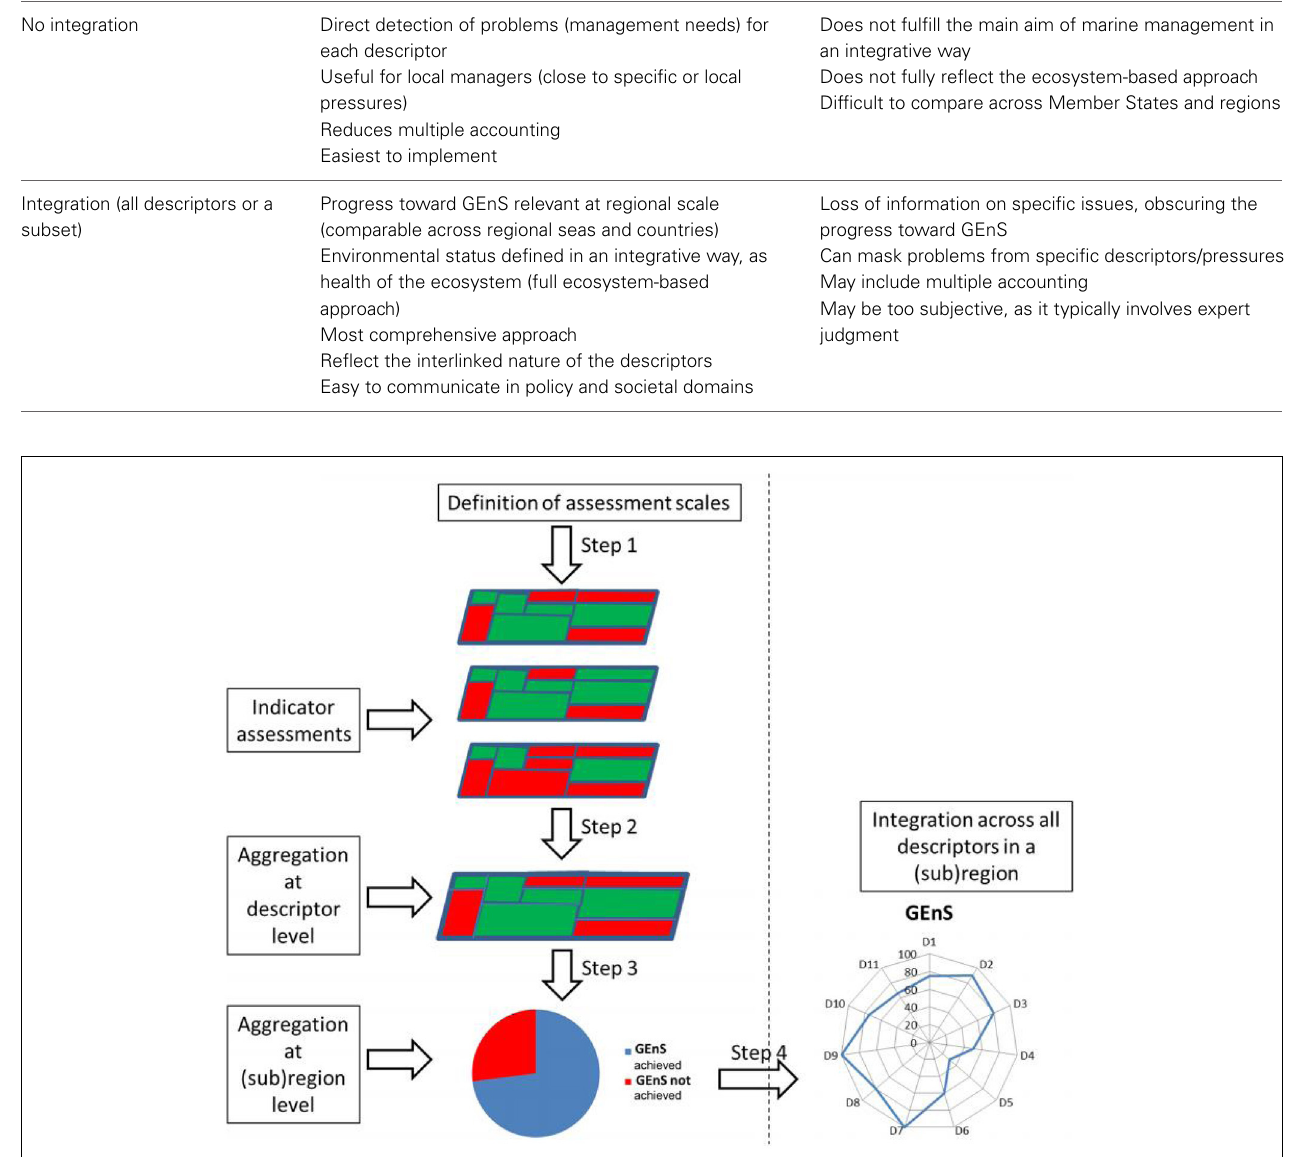
FIGURE 4 | Schematic view of steps for combination toward an assessment at subregional level. GEnS: Good Environmental Status.